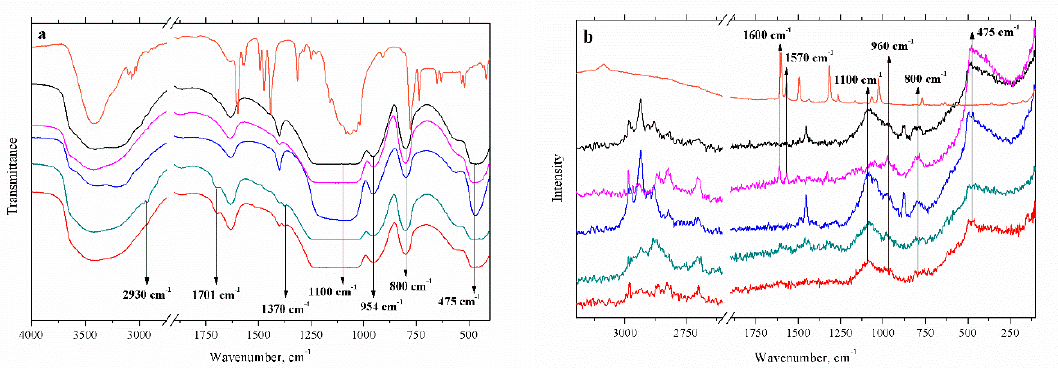
Figure 5. IR ( a ) and Raman ( b ) spectra of Co II (bpy) 3 (orange), SiO 2 (black) and Co II @SiO 2 synthesized by the w/o on the basis of Co II (bpy) 3 (cyan) and CoCl 2 (red) and by Stöber on the basis of Co II (bpy) 3 (magenta) and CoCl 2 (blue).